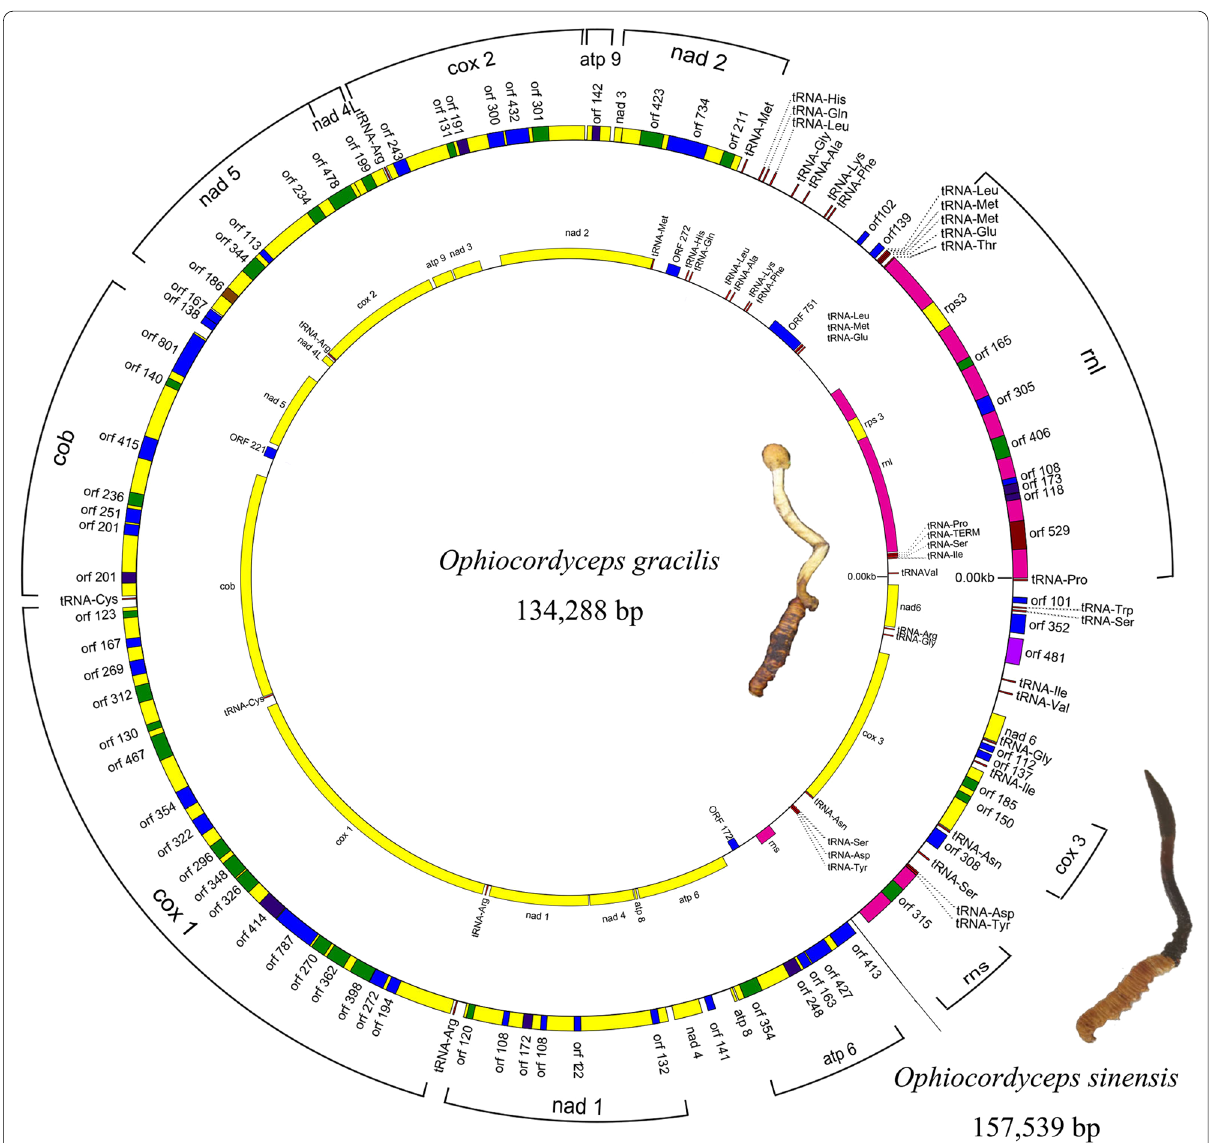
Fig. 1 Mitogenome map of Ophiocordyceps gracilis and O. sinensis . The outer layer represents O. sinensis obtained from Kang et al. (2017); the inner layer represents O. gracilis from this study. The genes are shown in different color